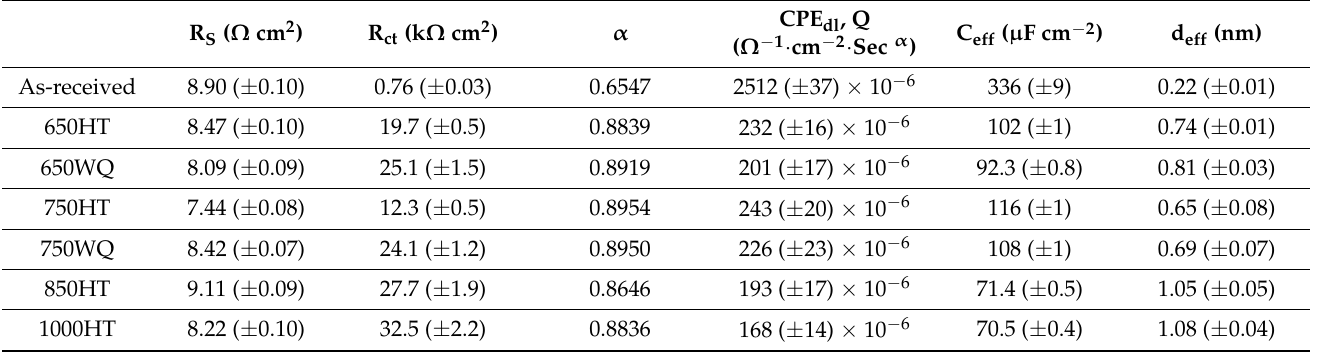
Table 4. Fitting parameters of the EIS measured in Ringer solutions for the as-received and heat-treated AM Ti–6Al–4V alloys after the E-CLCT tests.